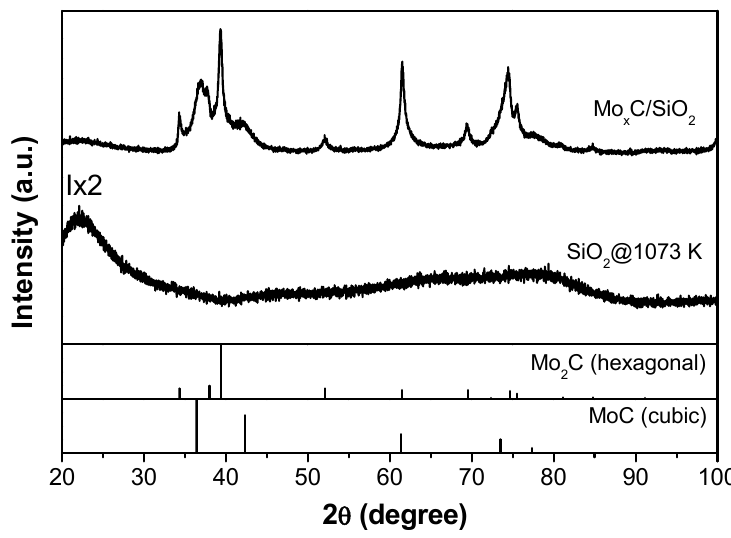
Figure 2. XRD patterns of Mo x C/SiO 2 catalyst and the SiO 2 support after thermal treatment at 1073 K.